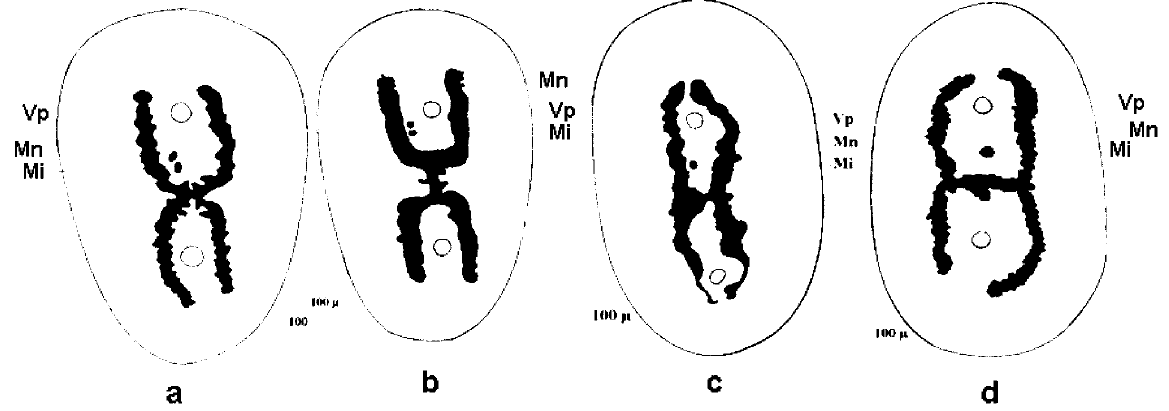
Fig. 1. – Variations morphologiques de l’appareil nucléaire chez Almophrya bivacuolata. Vp : vacuole pulsatile ; Mn : macronoyau ; Mi : micronoyau ; a : macronoyau en “X” et deux micronoyaux ; b : macronoyau de forme tran- sitoire entre “X” et “H” et deux micronoyaux ; c et d : macronoyau en “H” et un